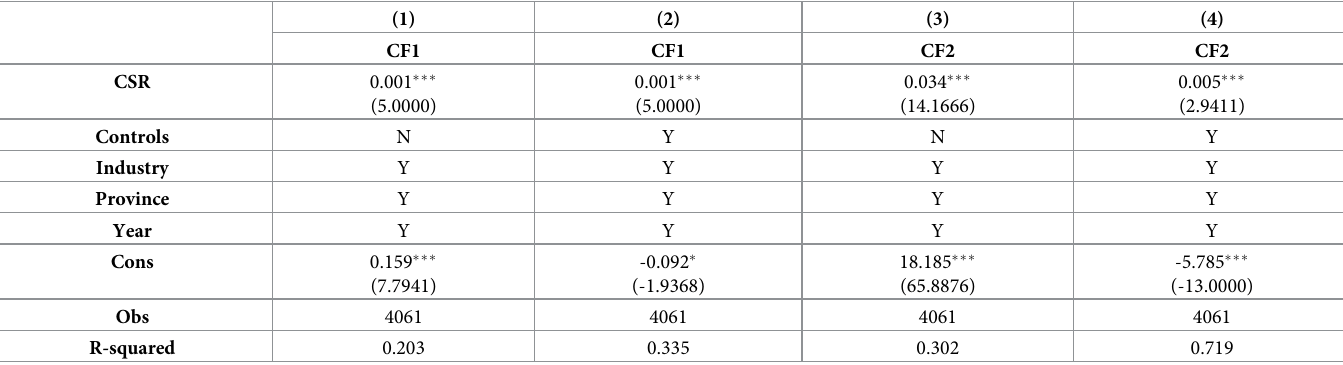
Table 11. Robustness test: rksCSR